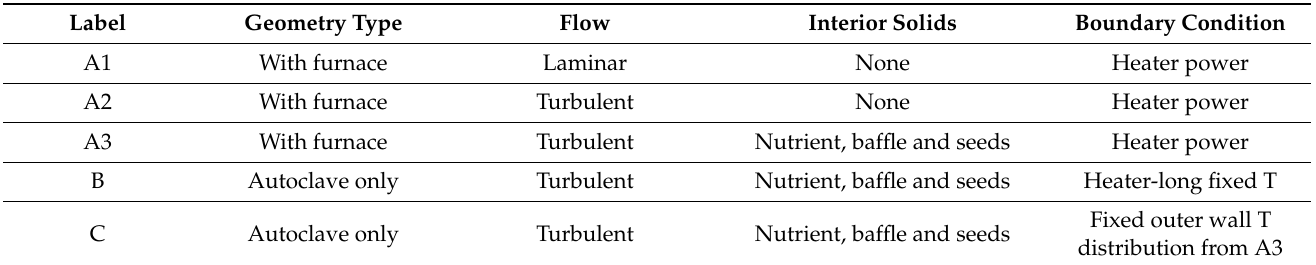
Table 4. Overview of simulation cases relating them to their label in the text and